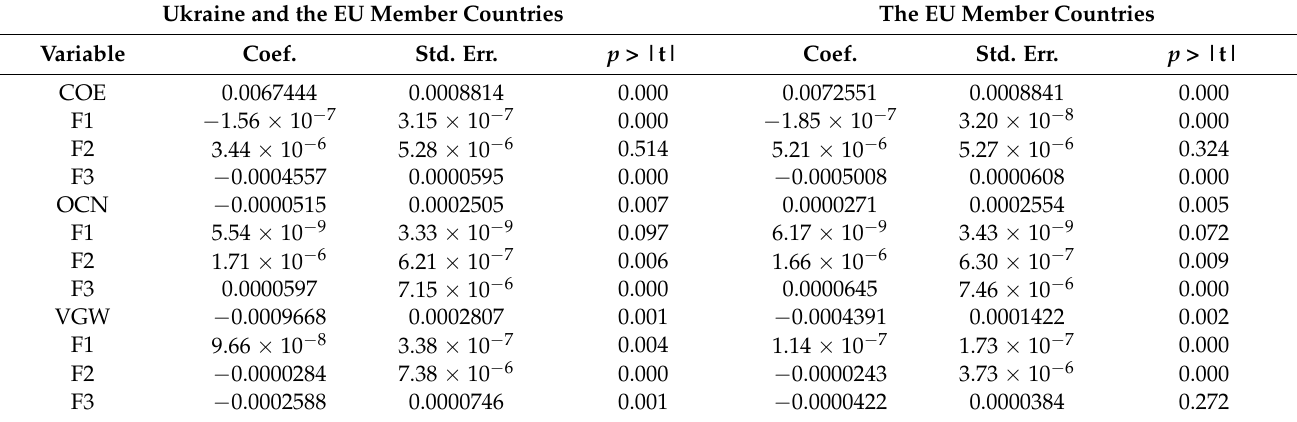
Table 2. The results of the calculation assessing β -convergence of energy efficiency indicators in the environmental sphere.